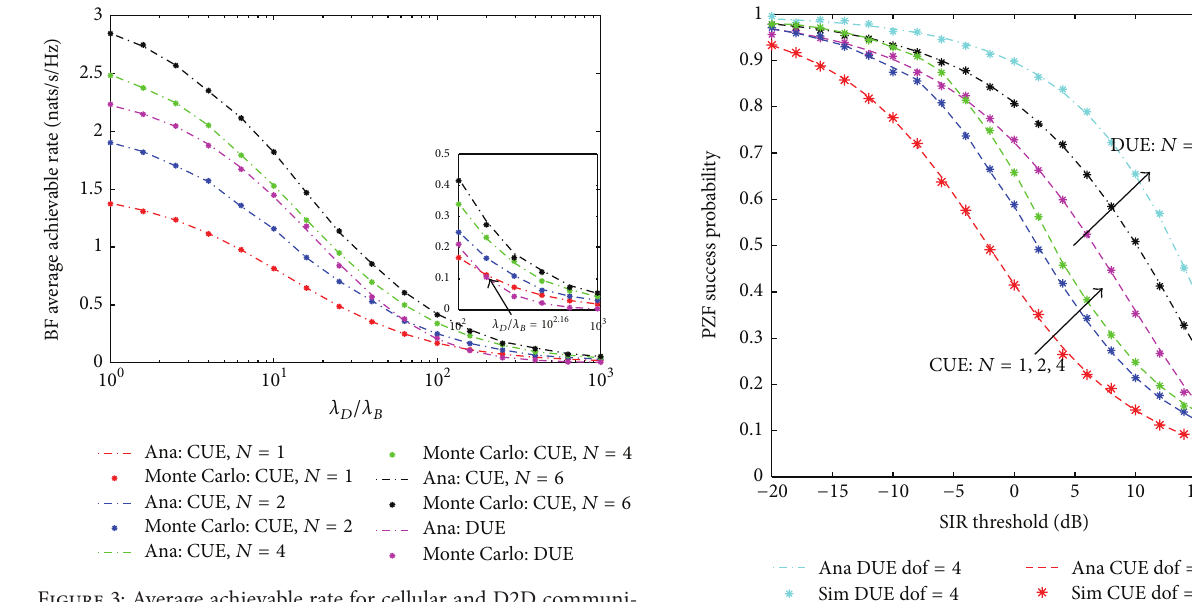
Figure 3: Average achievable rate for cellular and D2D communi- cation in BF strategy.